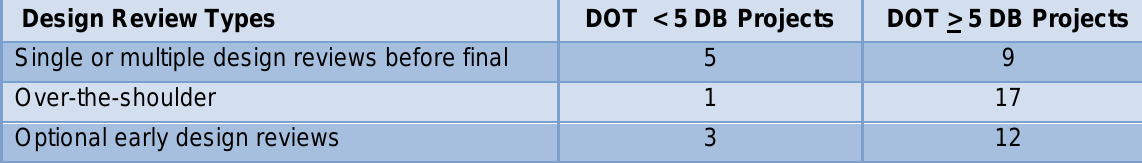
Table 4 Content analysis design review